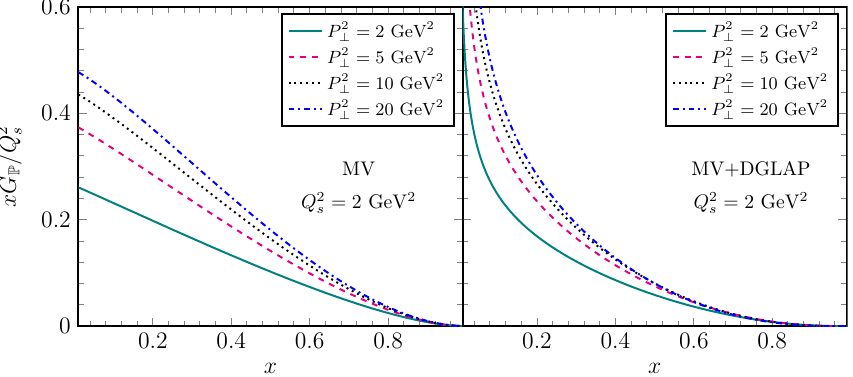
Figure 12 . The reduced Pomeron gluon distribution κ and obtained from the solution to the DGLAP equation, is plotted as a function of the rescaled momentum P 2 / ˜ Q 2 ( x, Y ) for various values of x and Y s ⊥ P equation is evaluated with the MV model. Right panel: the source also includes the BK evolution of the gluon dipole amplitude.